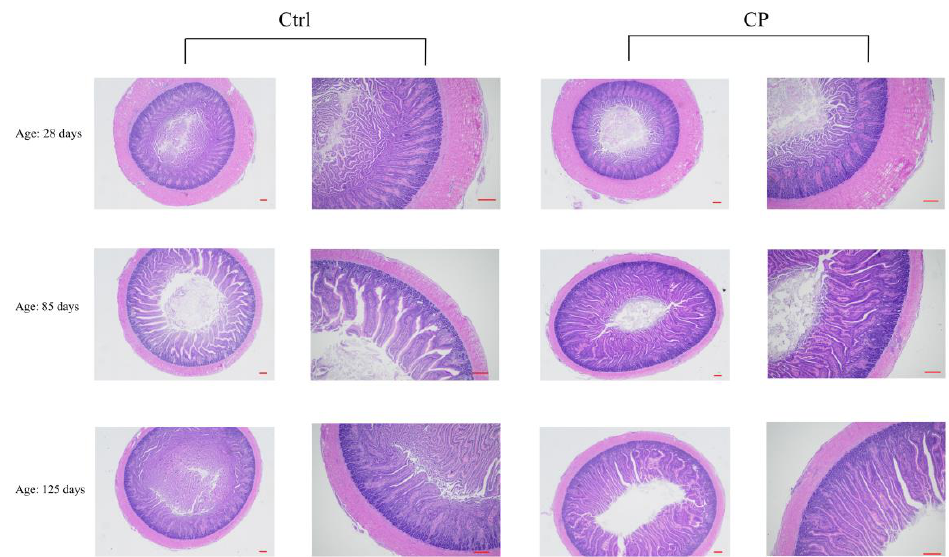
Figure 2. Compound probiotic effect on the morphological structure in the jejunum mucosa of ducks. Ctrl, basal diet, CP, basal diet supplemented with 0.15% compound probiotics. The first and third columns of the pictures are scaled to 100 µ m, and the second and fourth columns of the pictures are scaled to 50 µ m.